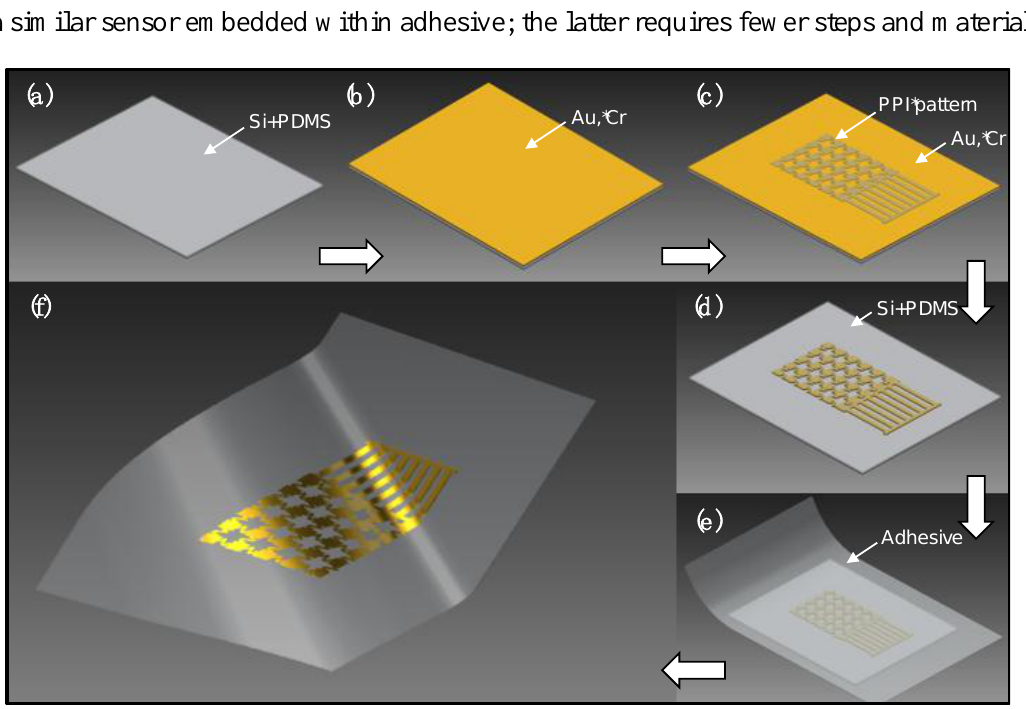
Figure 2. Fabrication process for electrical AP sensors: ( a ) formation of weakly-adhering donor; ( b ) metallization of Au and Cr films, respectively; ( c ) formation and patterning of PPI polymer backbone; ( d ) etch-back of Cr and Au films using PPI as etch mask; ( e ) flexible adhesive substrate adhered to pattern, ready for peel-off; and ( f ) pattern peeled-off onto receiving adhesive with Au surface exposed, ready for